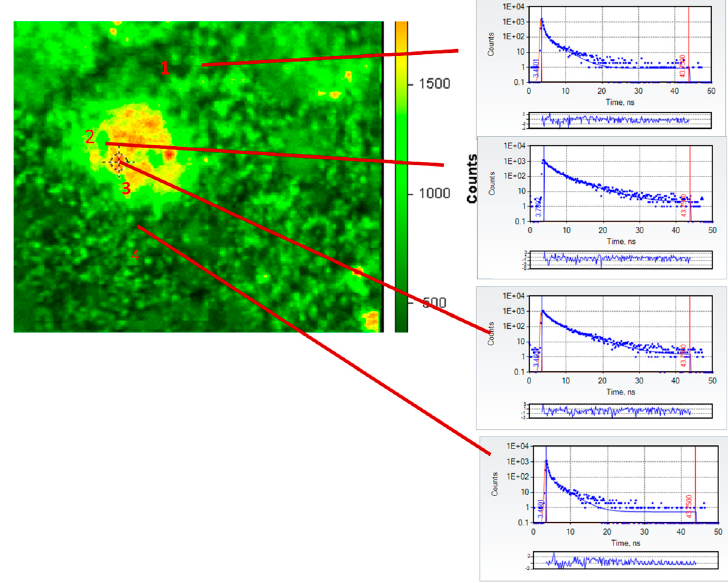
Figure 1. Fluorescence intensity micrograph (left) in false color of flat-mounted left retina of 82-year-old female (cause of death: congestive heart failure) following infusion with one liter of 500 mg/L Cl-Tet in PBS and a one-hour rinse with PBS. Excitation ≈ 442 nm (150 ps pulse width), emission 50 nm FWHM centered at 520 nm. Approximate size of the druse is 50 µ m. Time domain fluorescence lifetime imaging microscopy (TD-FLIM) data were collected on an ISS ALBA FLIM through a 20 × 0.4 objective, and those of indicated regions of interest (1–4) in the image fit to two components (time decays to right) with the fitted parameters summarized in Table